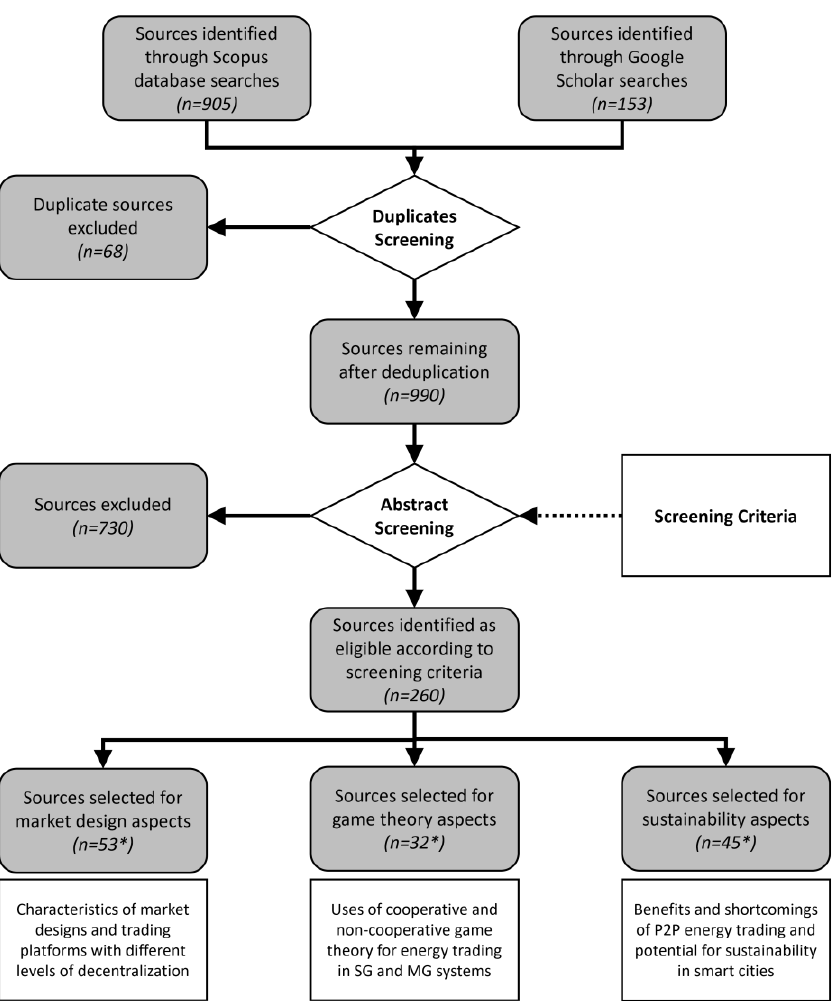
Figure 2. Flowchart of the methodology used to identify, select, and categorize literature publications (* certain sources address aspects related to market design, game theory, and sustainability, being therefore counted in multiple categories).